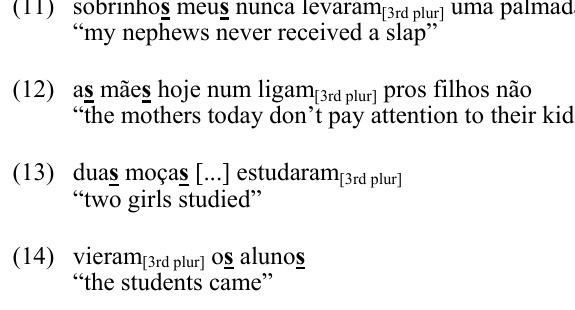
Pattern 3: full number agreement inside the Noun Phrase in subject position and Subject-Verb agreement (all